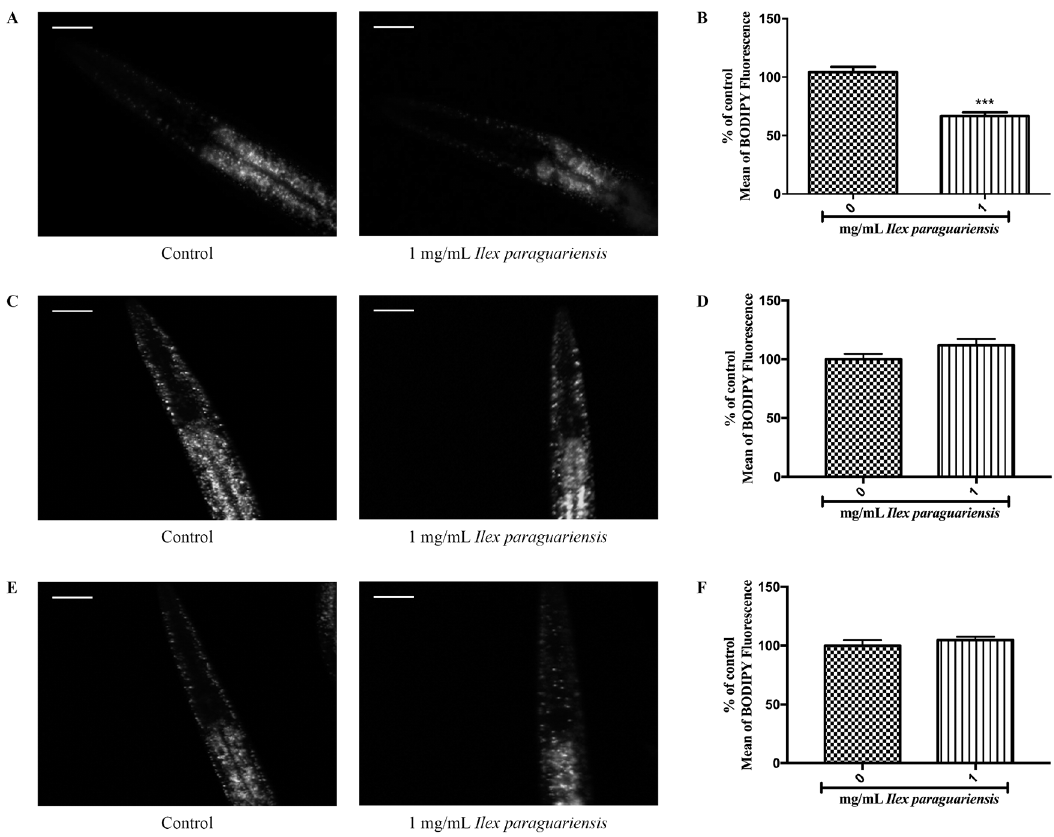
Fig 2. BODIPY fluorescence decrease induced by Ilex paraguariensis exposition in Caenorhabditiselegans wild-type (N2). Visualization of lipid droplets evidenced by BODIPY labeling in (A) wild-type young adults, (B) nhr-49(nr2041) ,and (C) ador-1 (ox489) and fluorescence quantification in (D) wild-type young adults, (E) nhr-49(nr2041) , and (F) ador-1(ox489) . (cid:3)(cid:3)(cid:3) p < 0.001, statistically significant compared with the untreated group by Student’s t -test (mean, SEM, n = 60 worms per group). The experiment was performed in